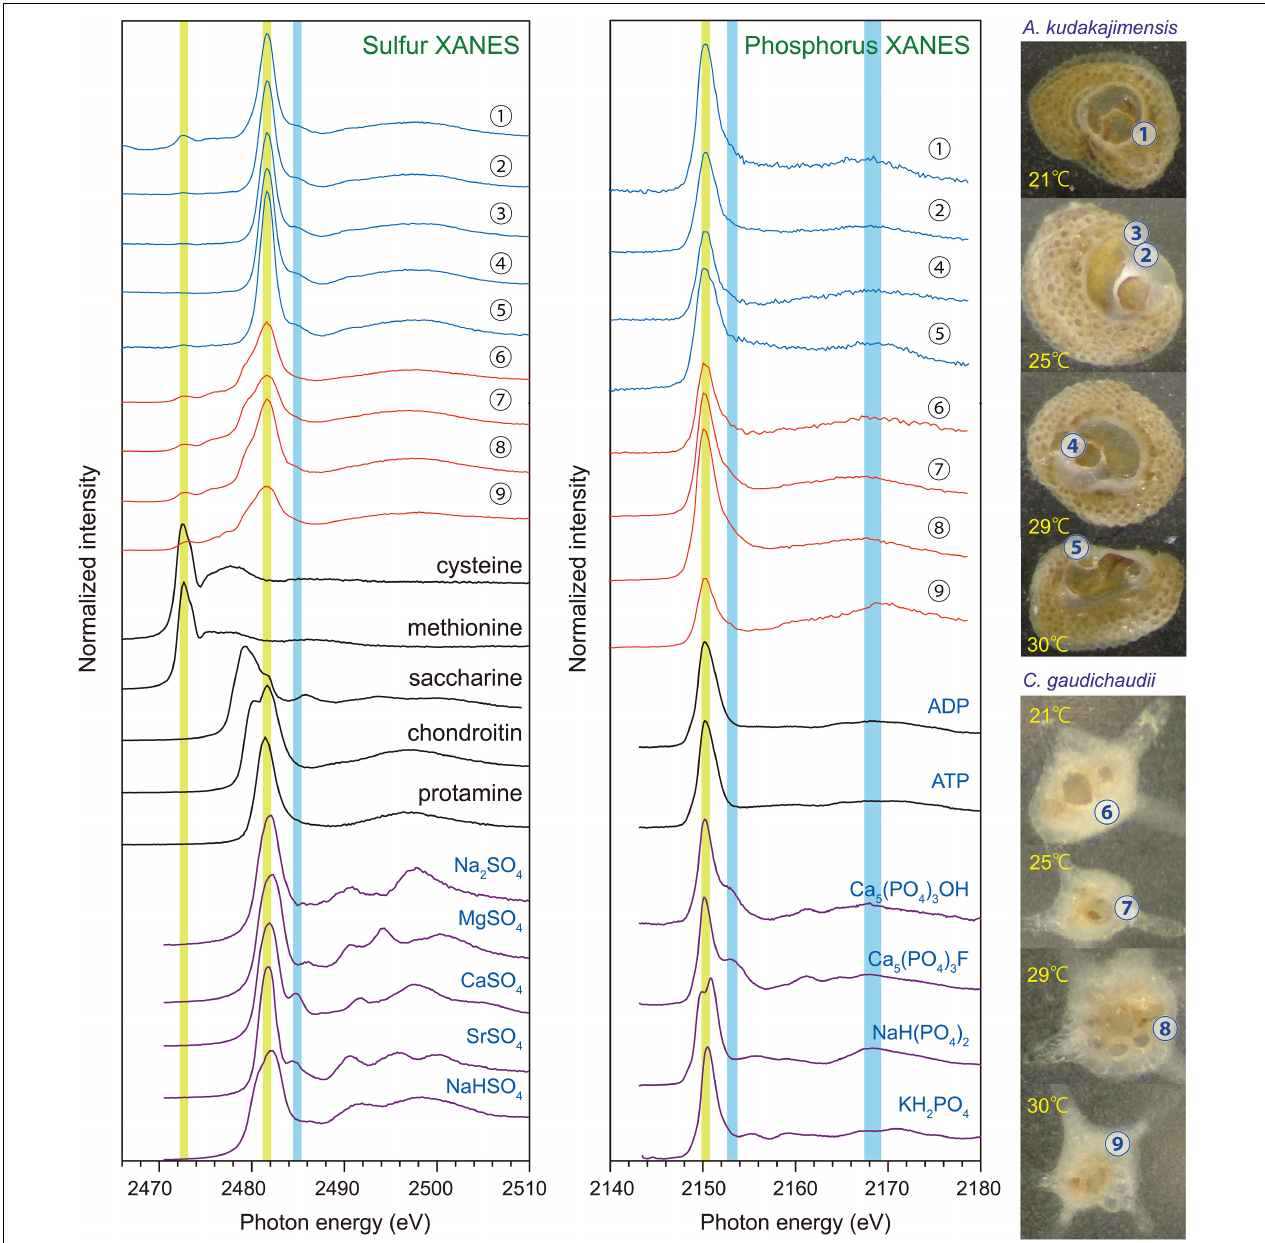
FIGURE 3 | S and P K-edge XANES spectra and photographs with the measurement points of in situ spot XANES analysis of cultured LBF species ( A. kudakajimensis : blue, C. gaudichaudii : red). The yellow and blue shades indicate the main peak components in LBF tests and some characteristic peaks of inorganic compounds, respectively. The reference spectra are presented for amino acids (cysteine and methionine) and organic sulfate and phosphate compounds (saccharine, chondroitin, protamine, ADP, and ATP, both shown in black), and inorganic compounds (purple) for fingerprinting identification.